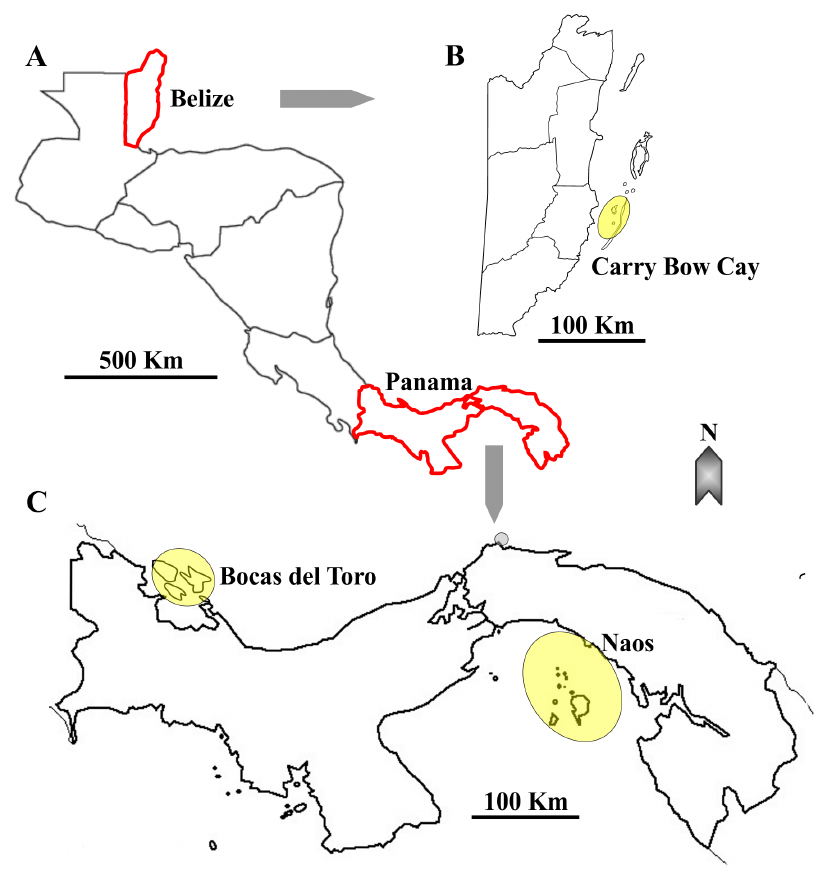
Figure 1. Map showing locations of sampling. A, view of Central America. Belize and Panama are indicated and their borders marked in red. B, close-up of Belize. The location of sampling, Carry Bow Cay, is indicated and highlighted within a yellow circle. C, Close-up of Panama. Bocas del Toro and Naos regions are each indicated and locations of sampling highlighted with a yellow circle.